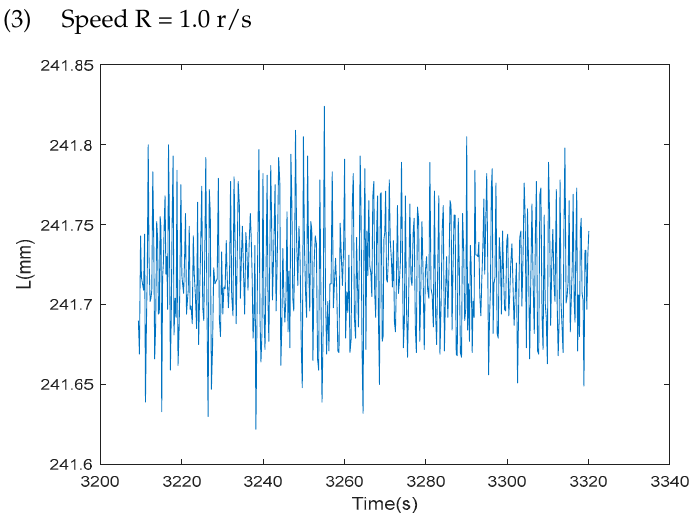
Figure 13. Measurement results of the distance between two targets at 1 r/s.